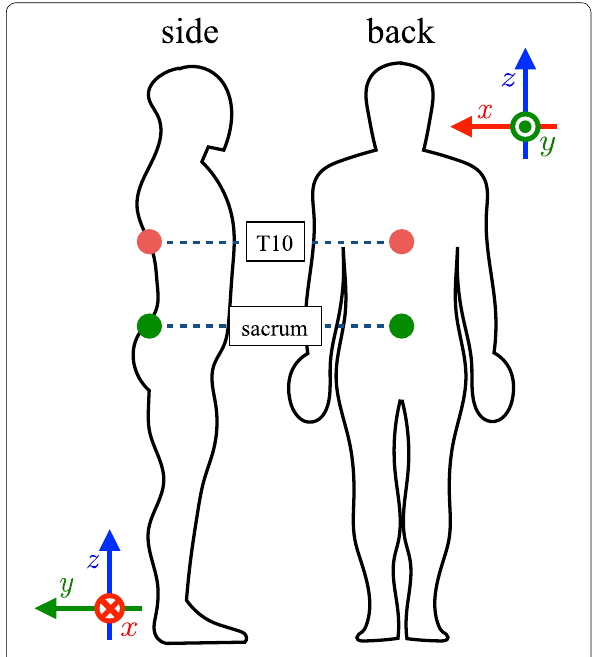
Fig. 6 Coordinate system of the subject’s body part measured by GRAIL. We put two makers on the subjects’ body; their sacrum and tenth thoracic vertebrae (T10)